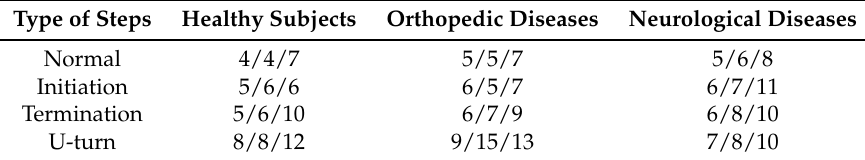
Table 4. Median absolute errors of ∆ Start, ∆ End, ∆ Duration (in samples) for different types of subjects and steps. Results are displayed as ∆ Start / ∆ End / ∆ Duration.